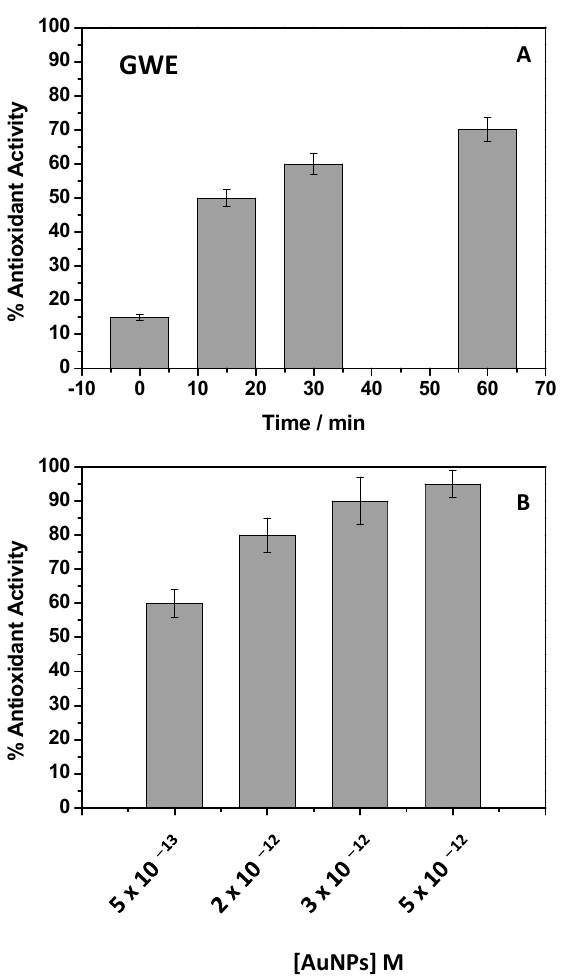
Figure 6. Percent of the antioxidant activities of raw GWE (2 mg/L), calculated at different incubation times in the presence of ABTS ( A ) and AuNPs at different concentrations ( B ).